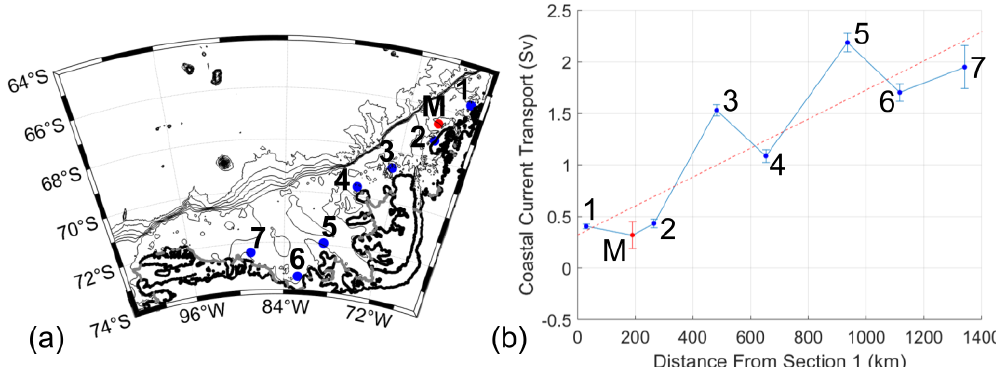
Figure 10. (a) Location of AACC transport estimates based on the hydrographic transects labeled as in Fig. 3, and (b) the values of transport (Sv; 1Sv = 10 6 m 3 s − 1 ) along the AACC. The transport increases as the AACC flows westward. The transport estimate from Moffat et al. (2008) in the WAP is included in both panels and indicated by the red dot labeled M. All of the transport values, except for the Moffat et al. (2008) section, are with respect to a level of no motion at 400m. The red dashed line shows a linear trend of 2Sv per 1000km. The blue dots in panel (a) indicate the midpoint of the AACC in each